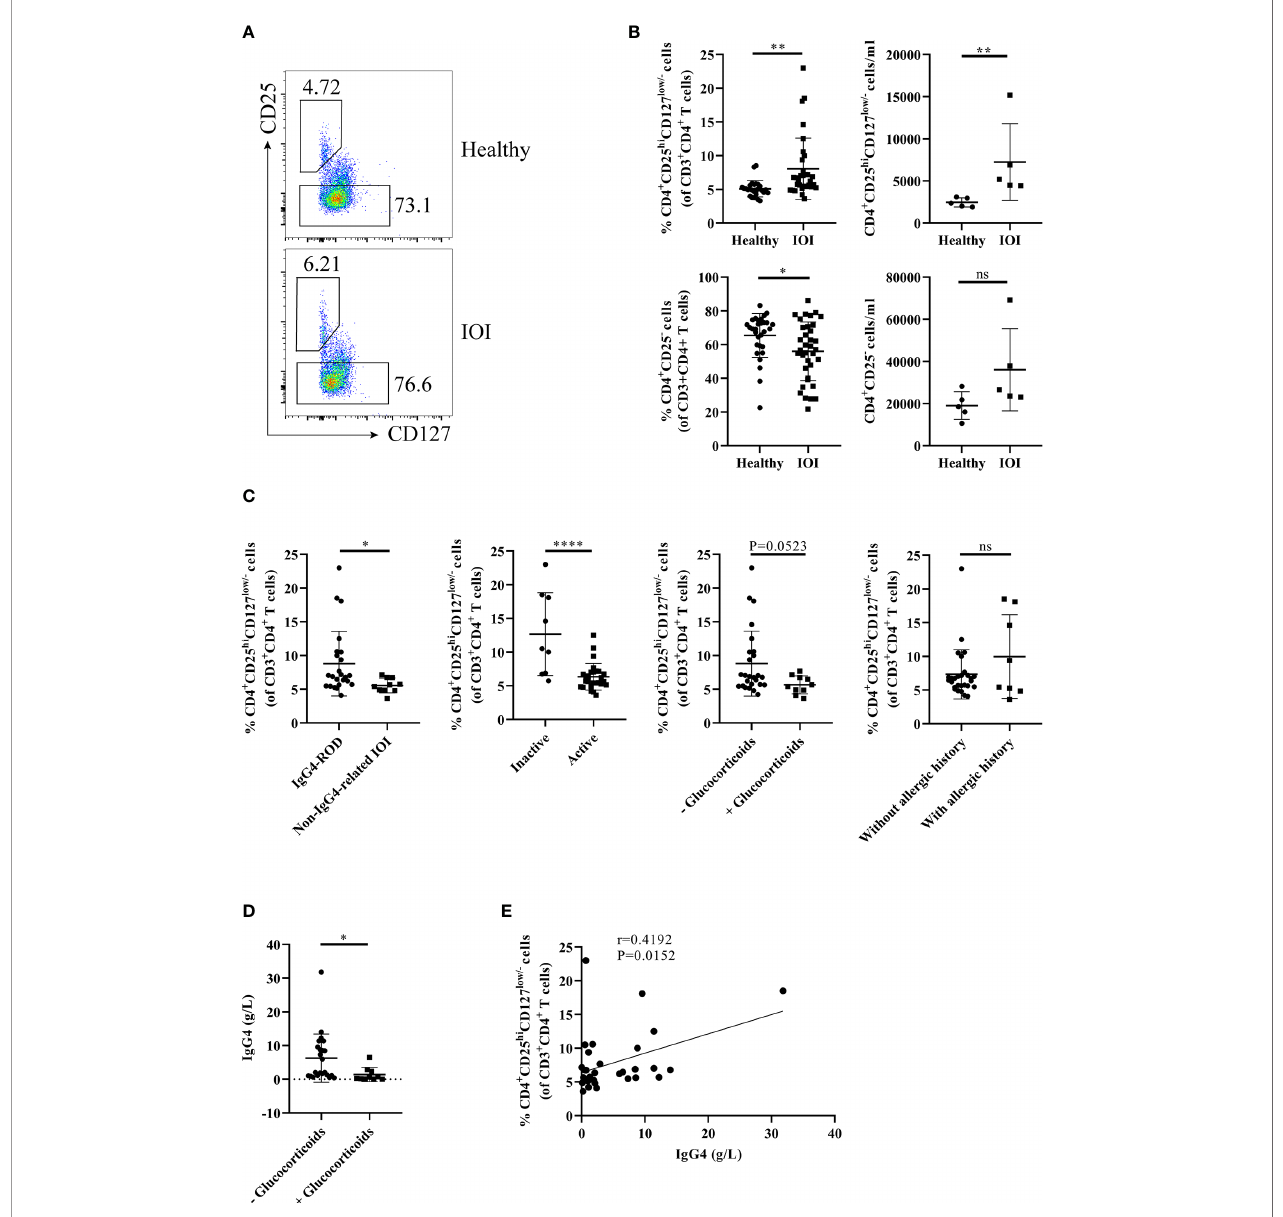
FIGURE 1 | The frequency of circulating regulatory T cells (Tregs) was increased in idiopathic orbital in fl ammation (IOI). The frequencies of Tregs in patients with IOI and healthy control subjects were evaluated by fl ow cytometry. (A, B) The frequencies and absolute number of circulating Tregs and conventional T cells (Tconvs) in healthy controls (n=30) and patients with IOI (n=36). (C) Frequencies of circulating Tregs compared between patients strati fi ed by IgG4-related disease (IgG4-RD), disease activity, allergic history and glucocorticoid therapy history status. (D) Compare the serum IgG4 between IOI patients with and without a history of glucocorticoids. (E) Association between circulating Tregs and serum IgG4 levels in patients with IOI. * P < 0.05; ** P < 0.01; **** P < 0.0001; ns, not signi fi